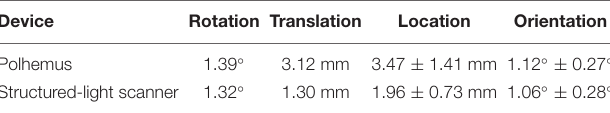
TABLE 6 | Final co-registration error of each device in the human experiment. Device